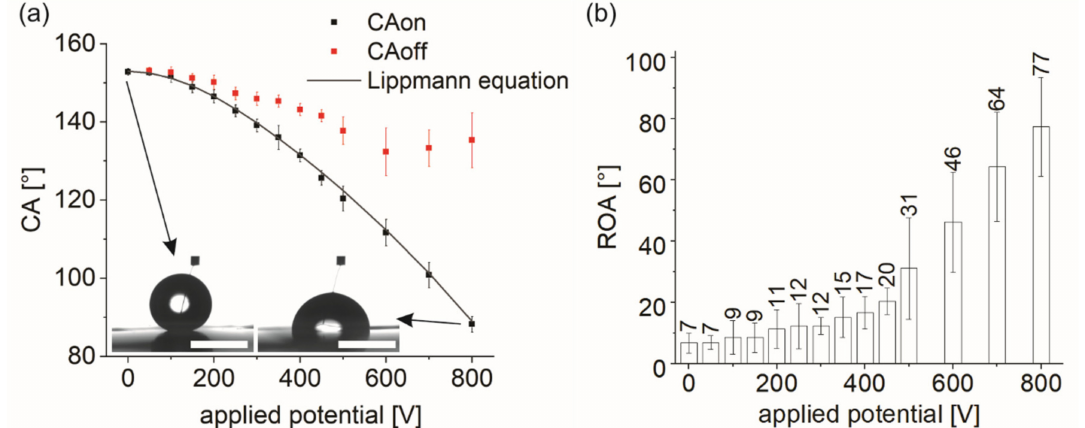
Figure 2. CA and ROA of water on Fluoropor (131 ± 16 µ m) in dependence of the applied potential. ( a ) The CA with applied potential (CA on !) decreased progressively with the increase of the applied potential. The analytical predication (black line) based on the Lippmann equation showed a good fit to the measured values. Two inset images show the actual water droplet shape at 0 V and 800 V applied potential. Scale bars: 2 mm. After the measurement, the potential was turned off and the contact angle was measured again (CA off !). The contact angle increased for all measurements but never decreased below 133 ± 6 ◦ . This indicated a wetting transition to a stable wetting state in which the droplet partly imbibed the porous structure above 400 V. ( b ) After measuring CA off , ROA was measured showing an increase in ROA with increasing potentials. This indicated that the droplet rolling off was inhibited by the intrusion of the liquid into the material and, therefore, a wetting transition from CB to a Wenzel